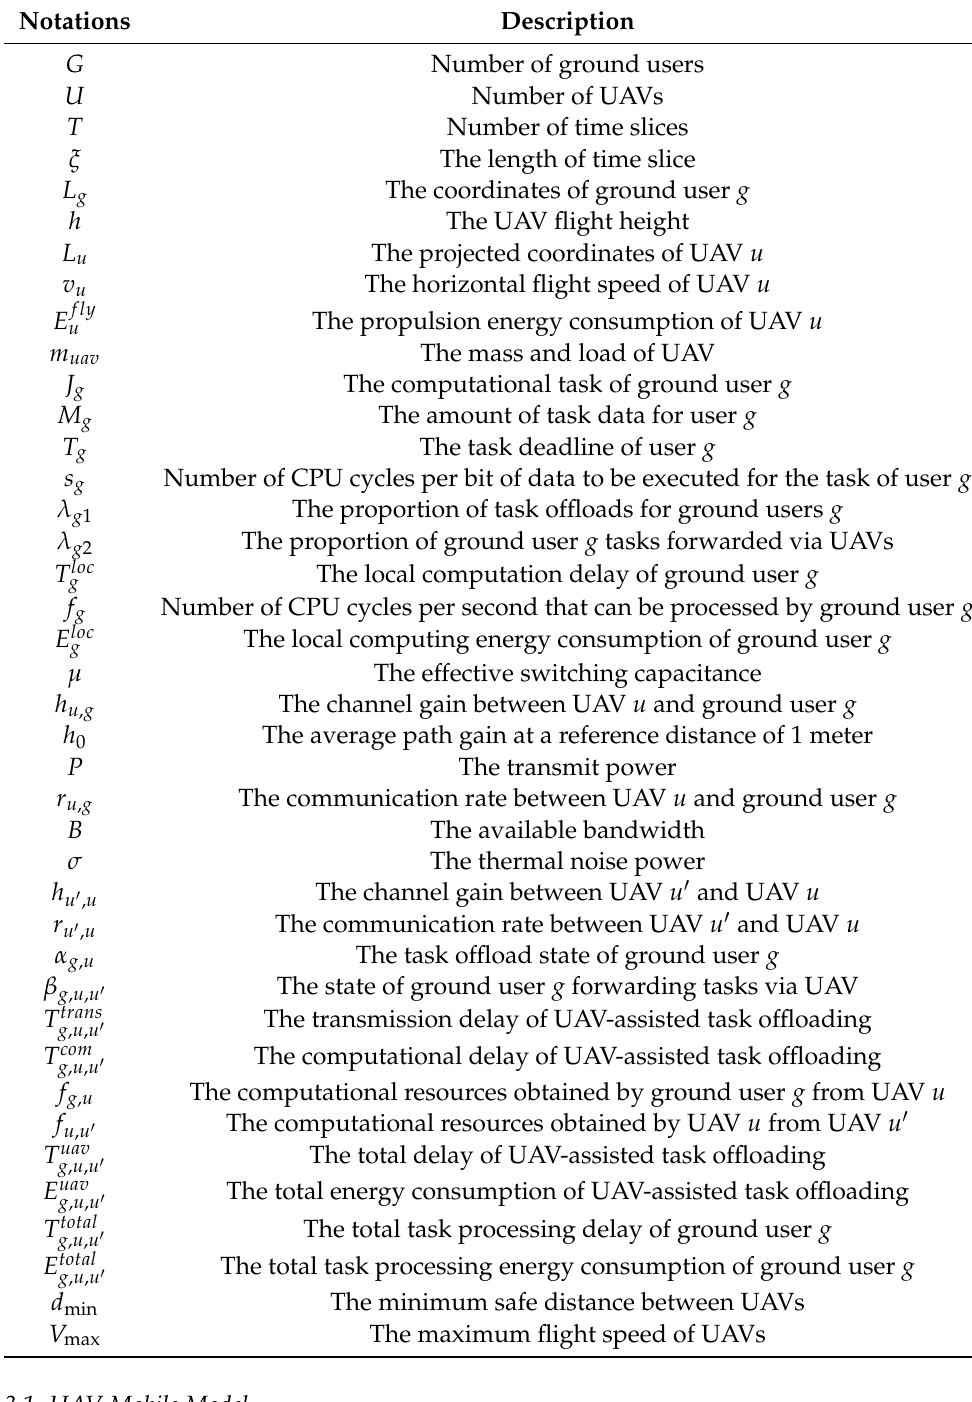
Table 1. Table of